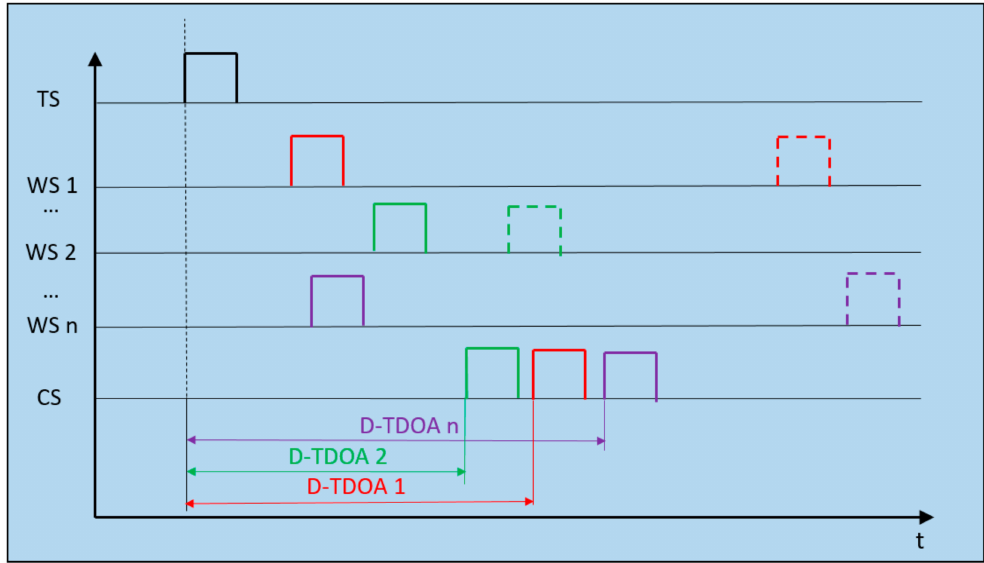
Figure 2. Di ff erence-Time Di ff erence of Arrival (D-TDOA) timing diagram. Example of architecture operation with n WS nodes (with a minimum number of 4). The positioning target pulse is received at every WS node of the system that retransmits it towards the CS node. D-TDOA time measurements are completed by a round-trip transmission (RTT) process between each pair of WS–CS